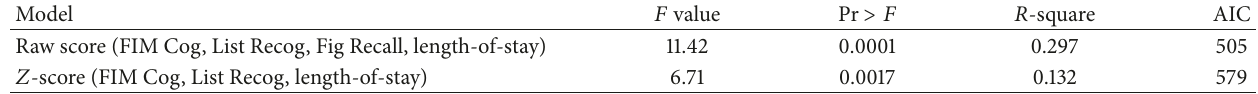
Table 3: Cognitive test scores predict FIM Motor Gain after contribution of FIM Cognition